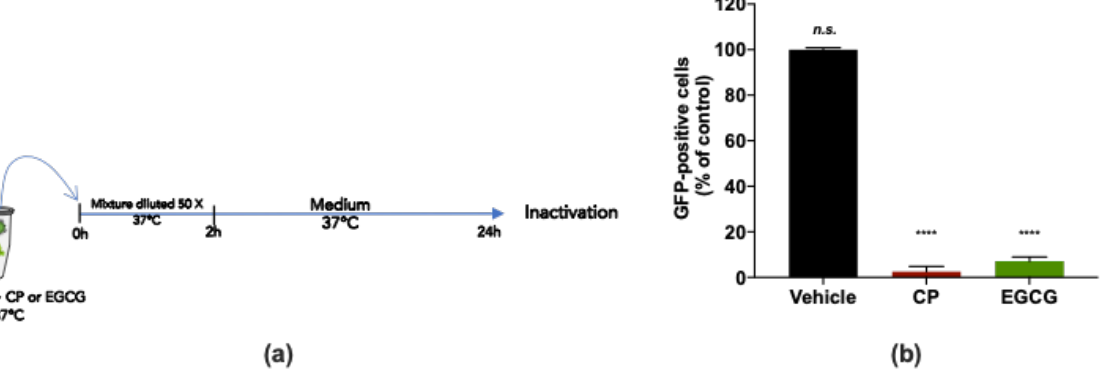
Figure 5. Cranberry pomace extract prevents virus entry by acting directly on ZIKV particles. ( a ) Schematic illustration of ZIKV inactivation assay performed to characterize the virucidal activity of the CP extract. ZIKV GFP was untreated (vehicle) or treated with the CP extract (100 µg/mL) for 2 h at 37 °C and subsequently diluted 50 times before infection of A549 cells. EGCG (100 µM) was used as a positive control. ( b ) Flow cytometric analysis under the experimental inactivation conditions shown in (a). The results are means ±SD of three independently performed experiments and are expressed as relative values to untreated infected cells. One-way ANOVA and Dunnett’s test were used for statistical analysis (**** p < 0.0001; n.s. = not significant).